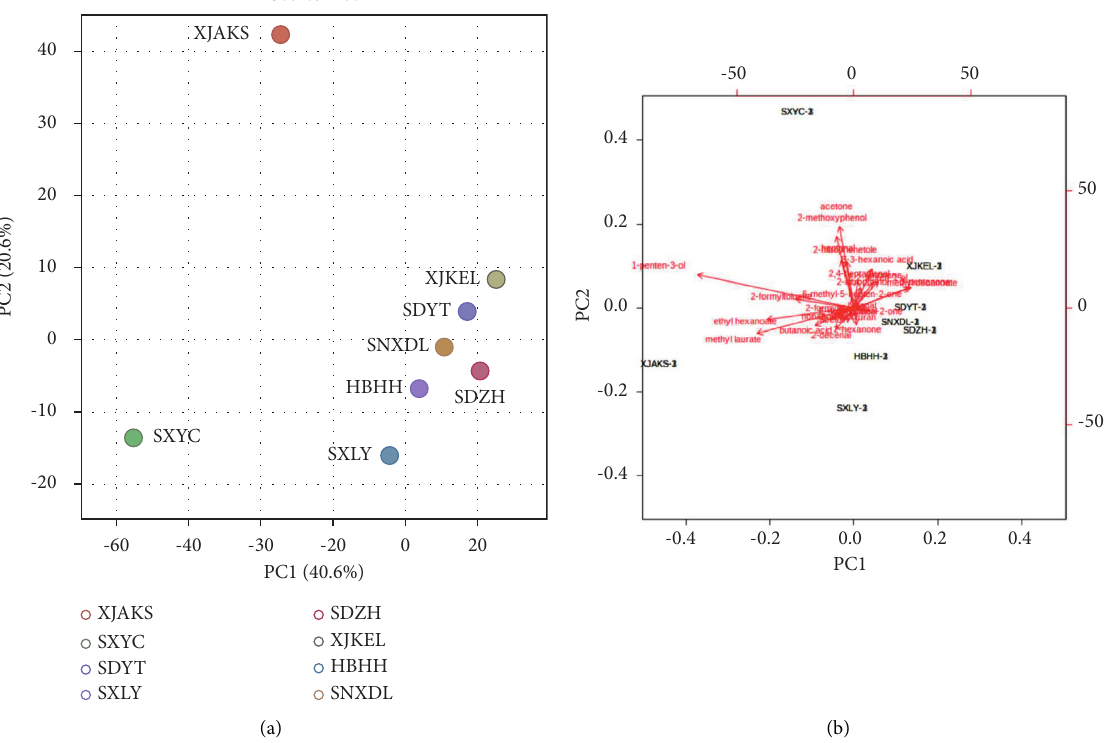
Figure 5: (a) PLS-DA analysis of the different cultivars of winter jujubes based on differential compounds. (b) Biplot analysis of the differential compounds in winter